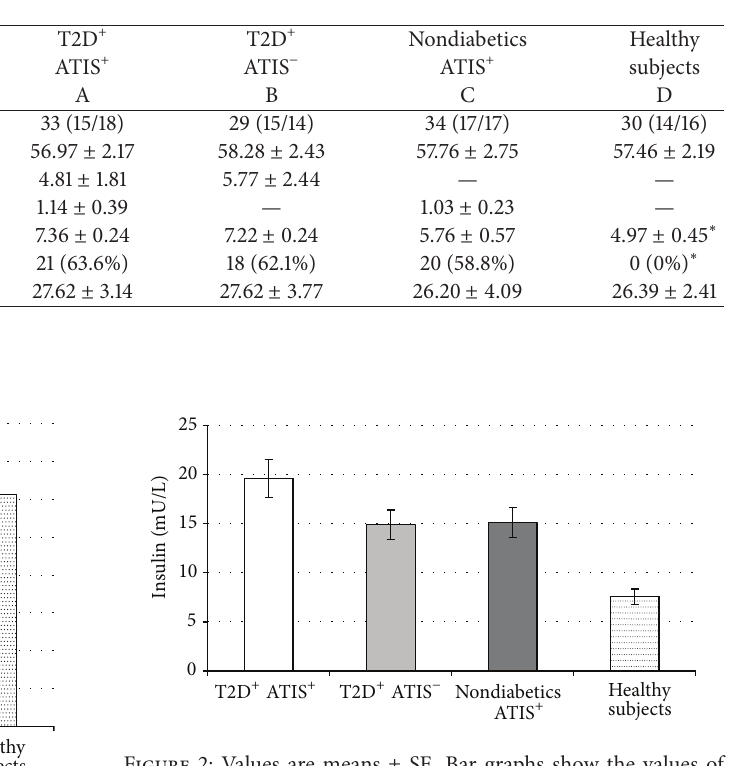
Figure 2: Values are means ± SE. Bar graphs show the values of basal PI level. PI levels were higher in type 2 diabetes (T2D) patients with atherothrombotic ischemic stroke (ATIS) compared to T2D patients without ATIS ( 𝑃 < 0.001 ) and in nondiabetics with ATIS in comparison to healthy subjects ( 𝑃 < 0.001 ). There is no difference in PI levels between T2D patients without ATIS and nondiabetics with ATIS ( 𝑃 = NS) (analysis of variance (ANOVA) with post hoc Tamhane test).